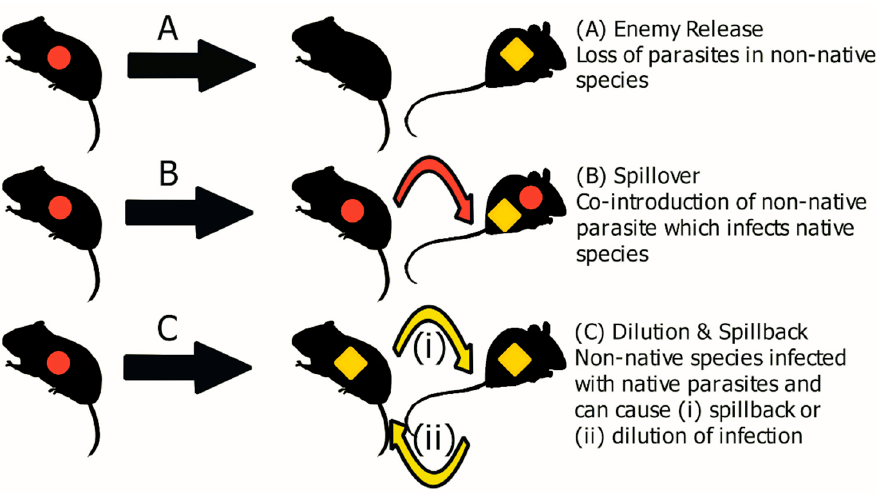
Figure 1. Disease dynamics of a biological invasion. Parasites introduced with the non-native species are indicated by red circles, while parasites from the native host are indicated by yellow diamonds. Adapted from Loxton [26] and Hatcher and Dunn [28].